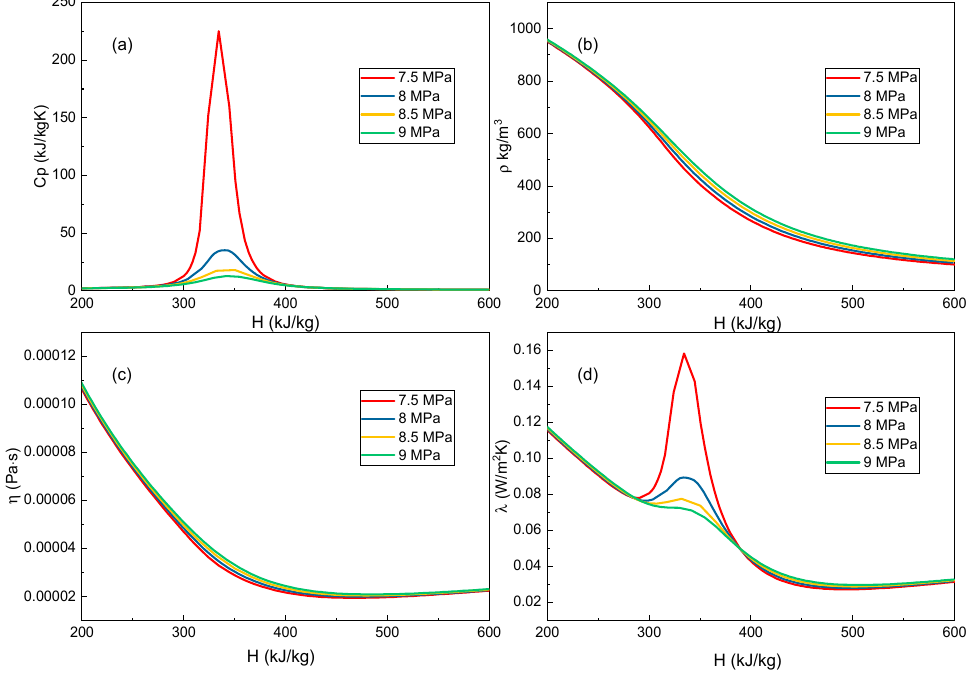
Figure 1. Variation in thermo-physical properties of CO 2 in the supercritical region at different pressures ( a ) specific heat; ( b ) density; ( c ) viscosity; ( d ) thermal conductivity.